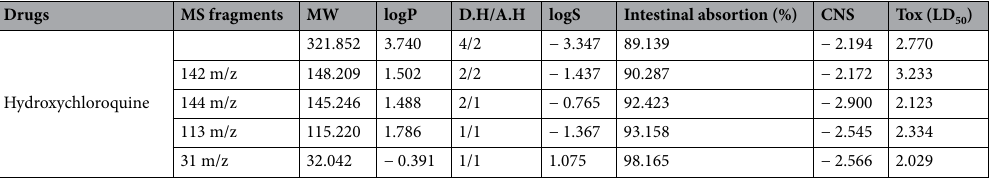
Table 2. ADMET profile of diverse anti-viral drugs and their metabolism fragments. ADMET parameters: MW molecular weight, D.H number of Hbonds donors, A.H. number of Hbonds acceptors, logP partition coefficient, logS predicted aqueous solubility (mol L −1 ), CNS predicted central nervous system, Tox Oral Rat Acute Toxicity (mol Kg −1